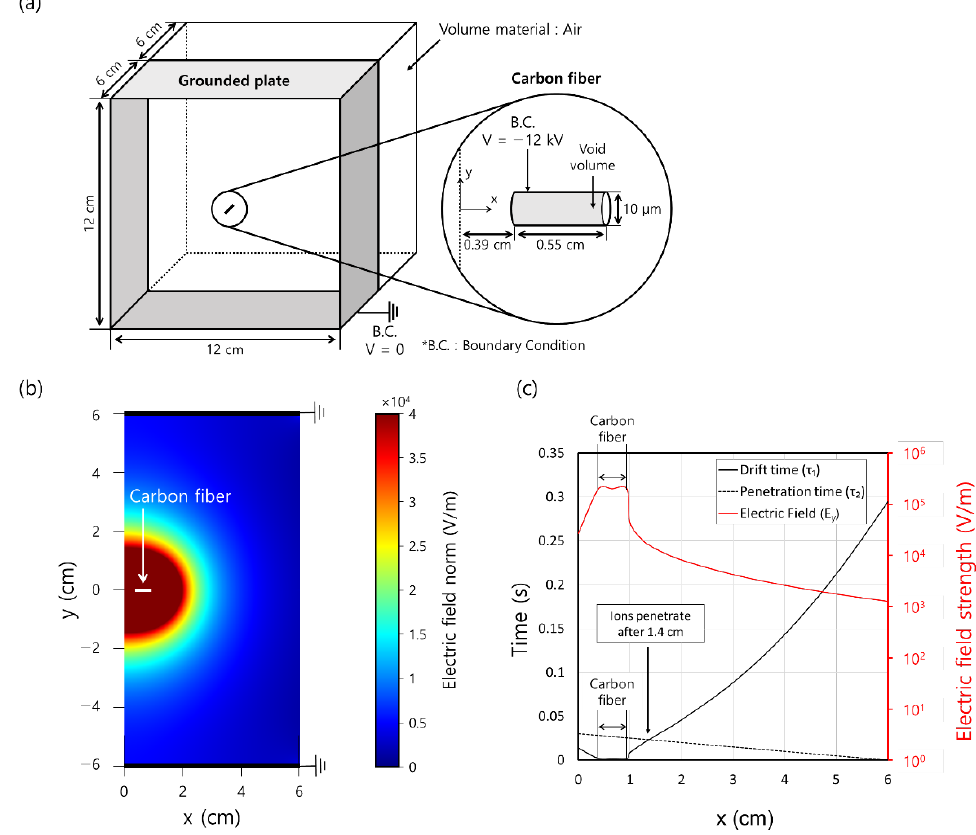
Figure 7. ( a ) Configuration of an ionizing channel used in COMSOL simulation. ( b ) Electric field distribution of a cross-section of the x - y plane of an ionizing channel. ( c ) Ion drift time, ion penetration time, and average electric field strength of the y -direction according to x.